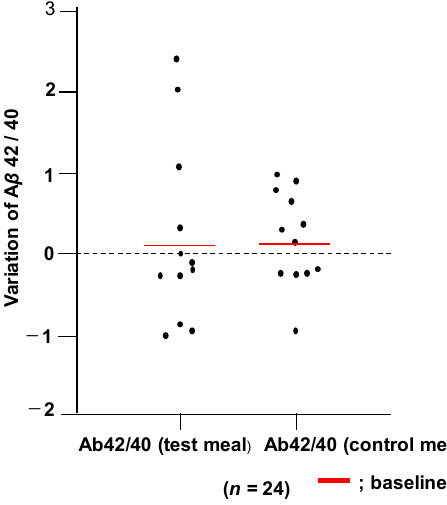
Figure 3. Changes of variation of amyloid β -42/4 peptide ratio by ELISA after 12 weeks .